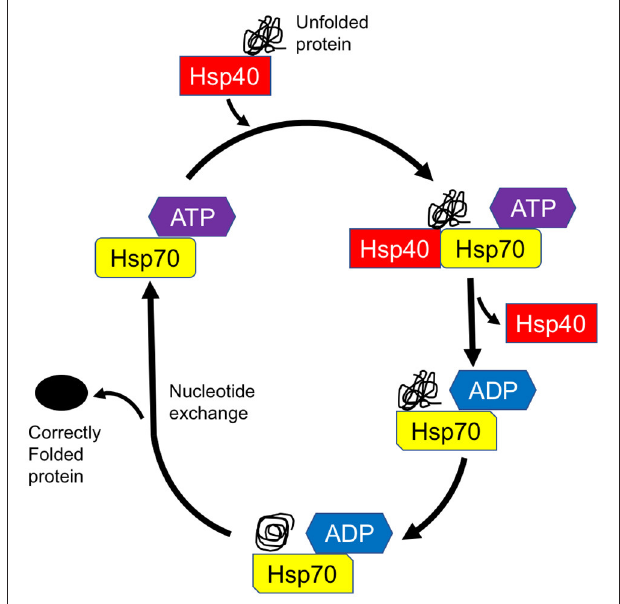
FIGURE 1 | Model of chaperone-assisted protein folding by Hsp70-DnaJ/Hsp40 complex. DnaJ/Hsp40 transiently associates with unfolded protein (substrate) for delivery of the substrate to Hsp70. Through the intermediary of the J domain, Hsp40 binds to Hsp70 and promotes its ATPase activity, thus generating the ADP-bound Hsp70, which stably interacts with client protein. After nucleotide exchange, the substrate is released from Hsp70 and leaves the cycle as a correctly folded protein.